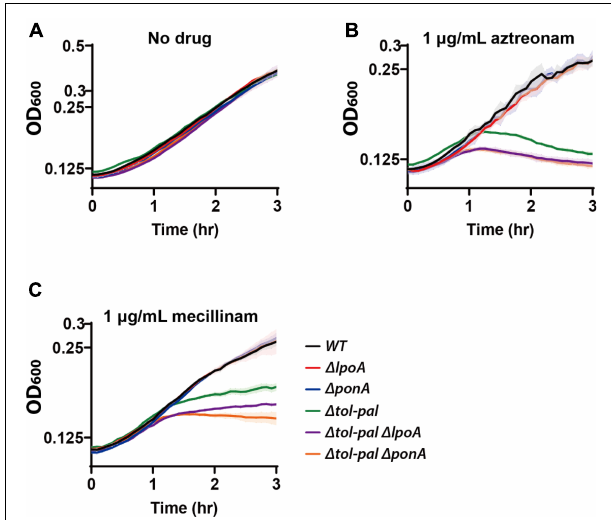
FIGURE 6 | Inactivation of the PBP1a-LpoA system aggravates the defects of the tol-pal mutant in maintaining cell integrity. MG1655 (wild type), WJ1 ( (cid:49) ponA ), SP37 ( (cid:49) lpoA ), SP23 ( (cid:49) tol-pal ), SP138 ( (cid:49) tol-pal (cid:49) ponA ), and SP139 ( (cid:49) tol-pal (cid:49) lpoA ) strains were grown overnight in LB at 30 ◦ C. The overnight cultures were diluted to an OD 600 of 0.02 in LB and grown to an OD 600 between 0.2 and 0.3 at 30 ◦ C. The exponential cultures were diluted to an OD 600 of 0.1 in plain LB (A) or LB containing either aztreonam (B) or mecillinam (C) at a final concentration of 1 µ g/ml and grown at 30 ◦ C. The optical density of the cultures was measured in triplicate in a 96-well microtiter plate at 30 ◦ C for 3 h with agitation after beta lactam treatment.